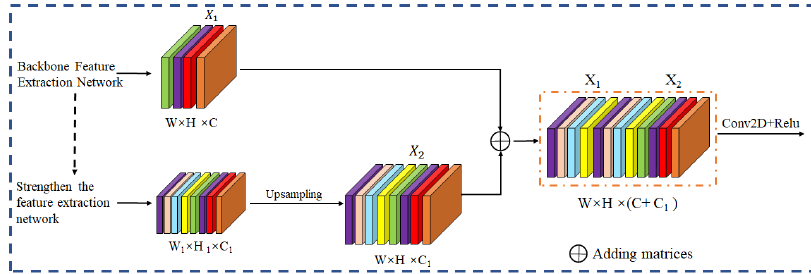
Figure 5. UNet structure diagram.